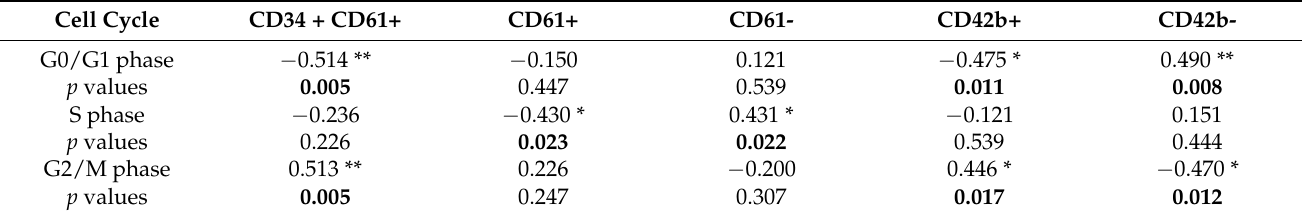
Figure 6. Intratumoral CD34 and Ki-67 expressions of PCa and BPH tissue samples. Legend: ( A ) CD34 positive vascular endothelial, intratumoral, 10–20 vessels/HPF, prostate adenocarcinoma, Gleason score 4 + 3 ( × 20); ( B ) CD34 positive intratumoral vasculature, 20–30 vessels/HPF adenocarcinoma, Gleason score 4 + 4 ( × 20); ( C ) Ki67 nuclear positive, score 1+, less than 25% of tumor cell proliferation 9 ( × 40); ( D ) Ki67 nuclear positive, score 1+, less than 25% of tumor cell proliferation ( × 40). Tissue Inflammation Grade, and Ki-67 Cell Proliferation in Tissue Samples Relationships between the DNA content and adhesion glycoproteins are presented in Table 6. Pearson correlations were observed between the G0/G1 phase of cell cycle and CD34+ CD61+ glycoproteins (r = − 0.514; p < 0.01), and CD42b+ cell population (r = − 0.475; p < 0.05), between G2/M phase of cell cycle and CD34+ CD61+ glycoproteins (r = 0.513; p < 0.01), and CD42b+ cell population (r = 0.446; p < 0.05), between S phase and CD61+ cell population (r = − 0.430; p < 0.05, Table 6). Table 6. DNA content and adhesion glycoproteins expressions